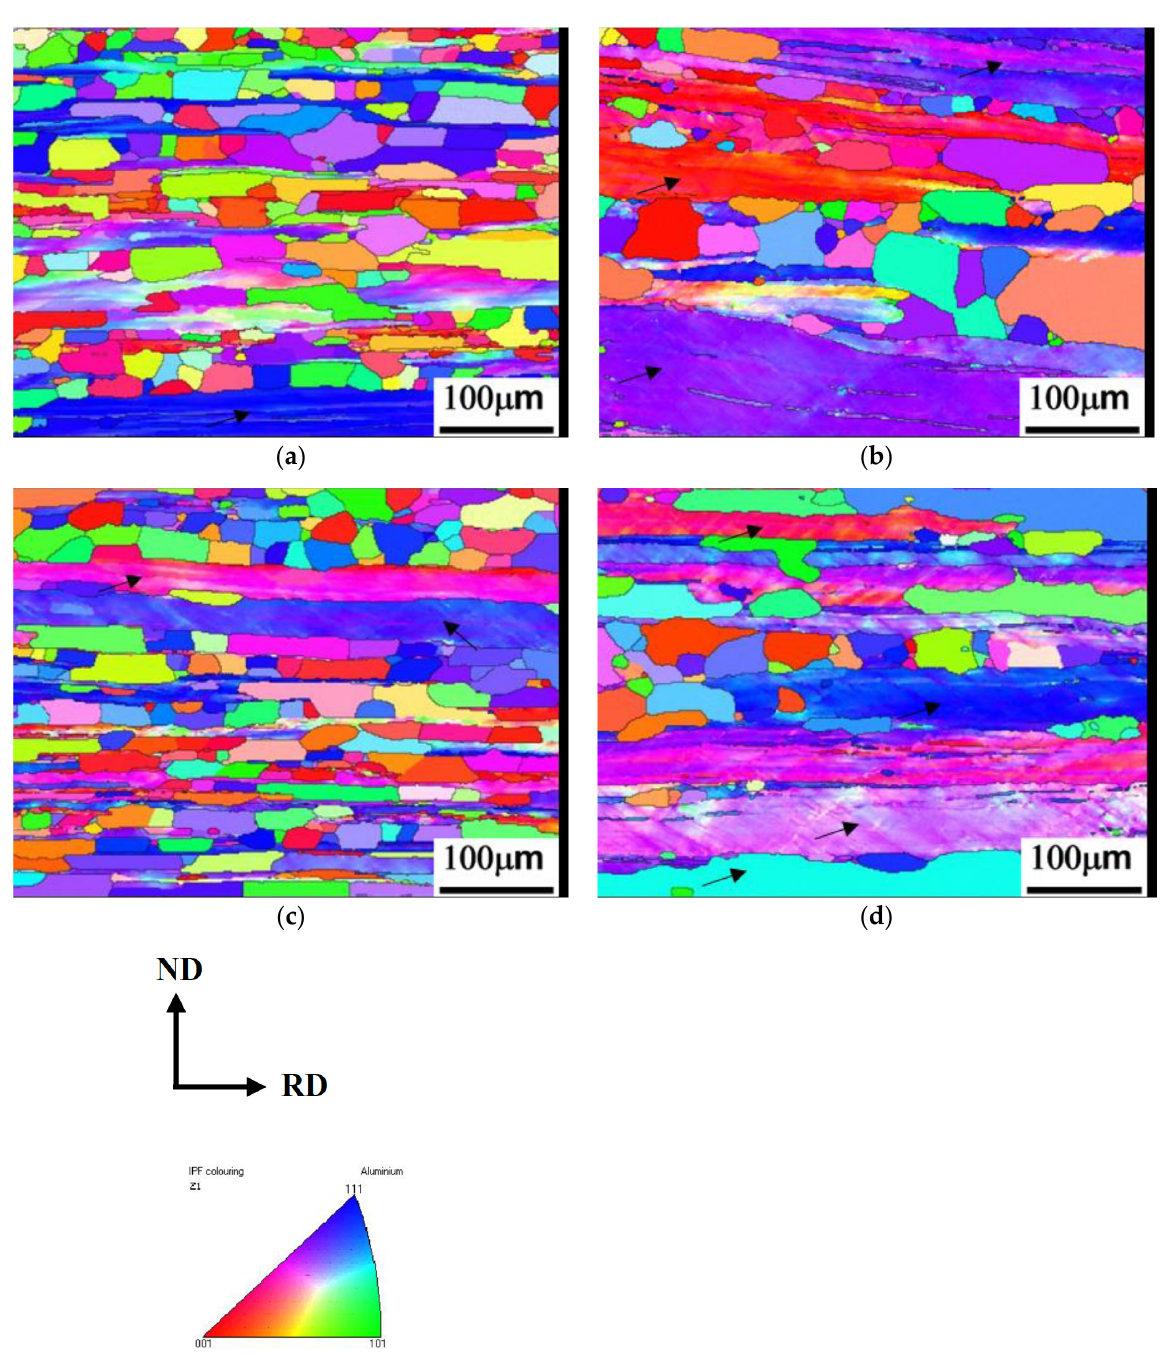
Figure 6. Euler angle colored electron backscattered diffraction (EBSD) maps of T6 state of ( a ) 1-Hom. alloy A(0.1Zr); ( b ) 1-Hom. alloy B(0.05Sc); ( c ) 2-Hom. alloy A(0.1Zr); ( d ) 2-Hom. alloy B(0.05Sc); ( e ) IPF(Inverse Pole Figure) coloring map and cross-sectional direction. ND, normal direction; RD, rolling direction.